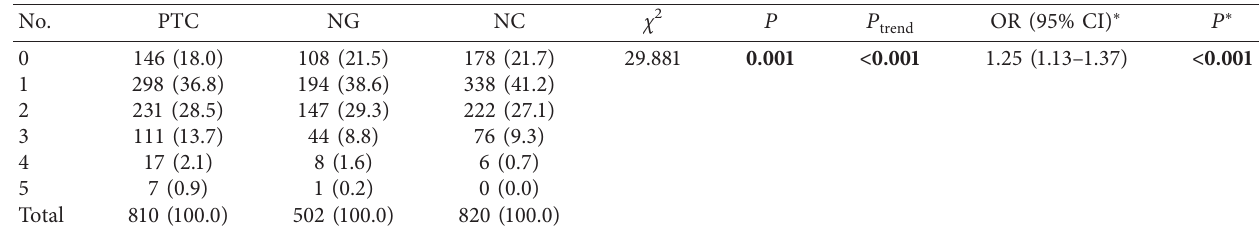
Table 6: Cumulative risk alleles of the three SNPs and association with